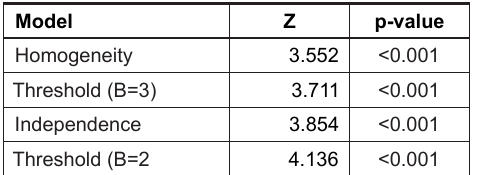
Table 18. Tests for randomness of collared caribou for the Bluenose-West 2012 data set.